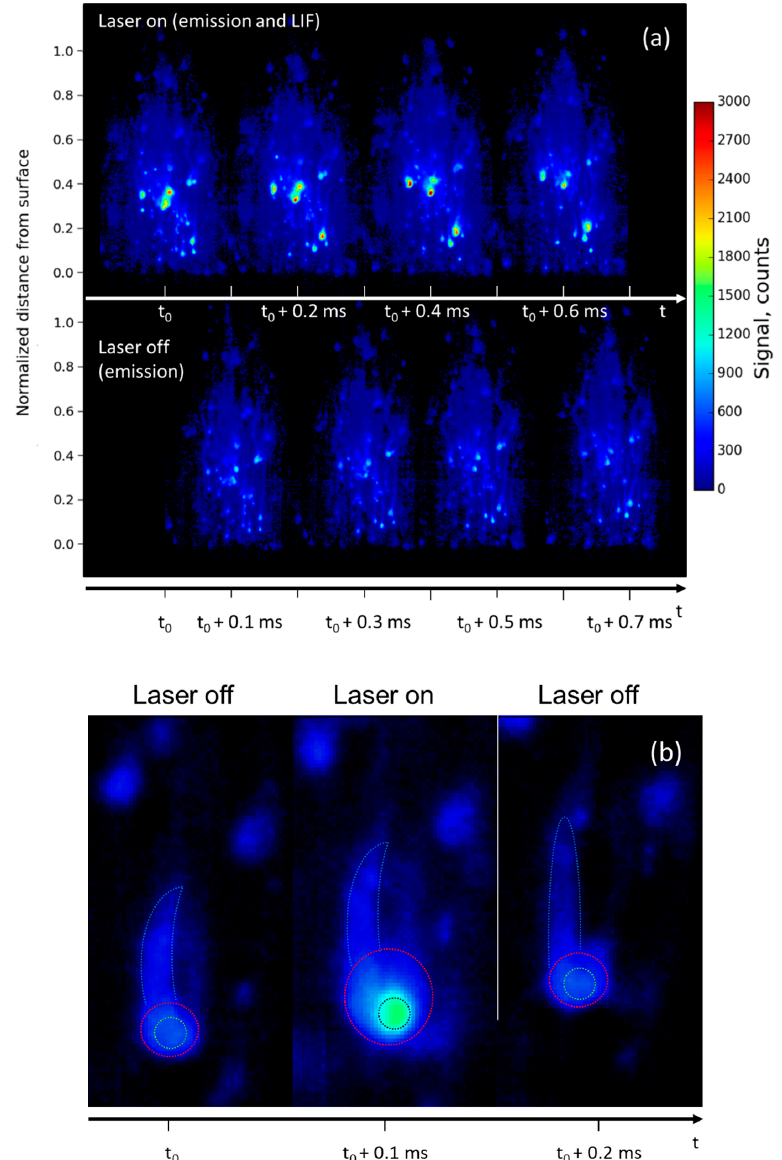
Figure 2. ( a ) Comparison between two sequences of four instantaneous images of laser-induced fluorescence (LIF) signal (with laser on, top sequence) and emission signal (without laser, bottom sequence). The distance from surface is normalized to the total flame height. The time delay between successive images is 0.1 ms. The time delay between LIF images is 0.2 ms. The sequence duration is 0.8 ms. Images are recorded during the combustion of a burning Al / AP / HTPB propellant sample at 1.2 MPa. The dynamic of the signal is 3000 counts; ( b ) time sequence of three successive expanded images of a droplet extracted from Figure 2a at h = 3 mm. The color range is white for the particle core, red for the vapor extension, and blue for the plume